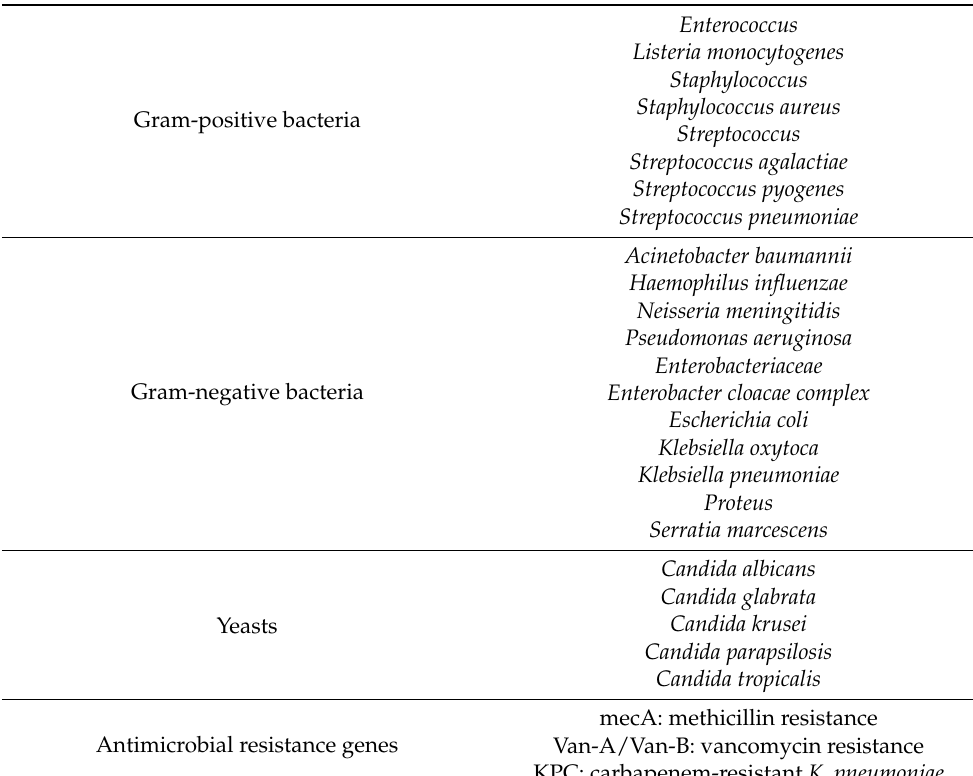
Table 1. FilmArray ® blood culture identification panel